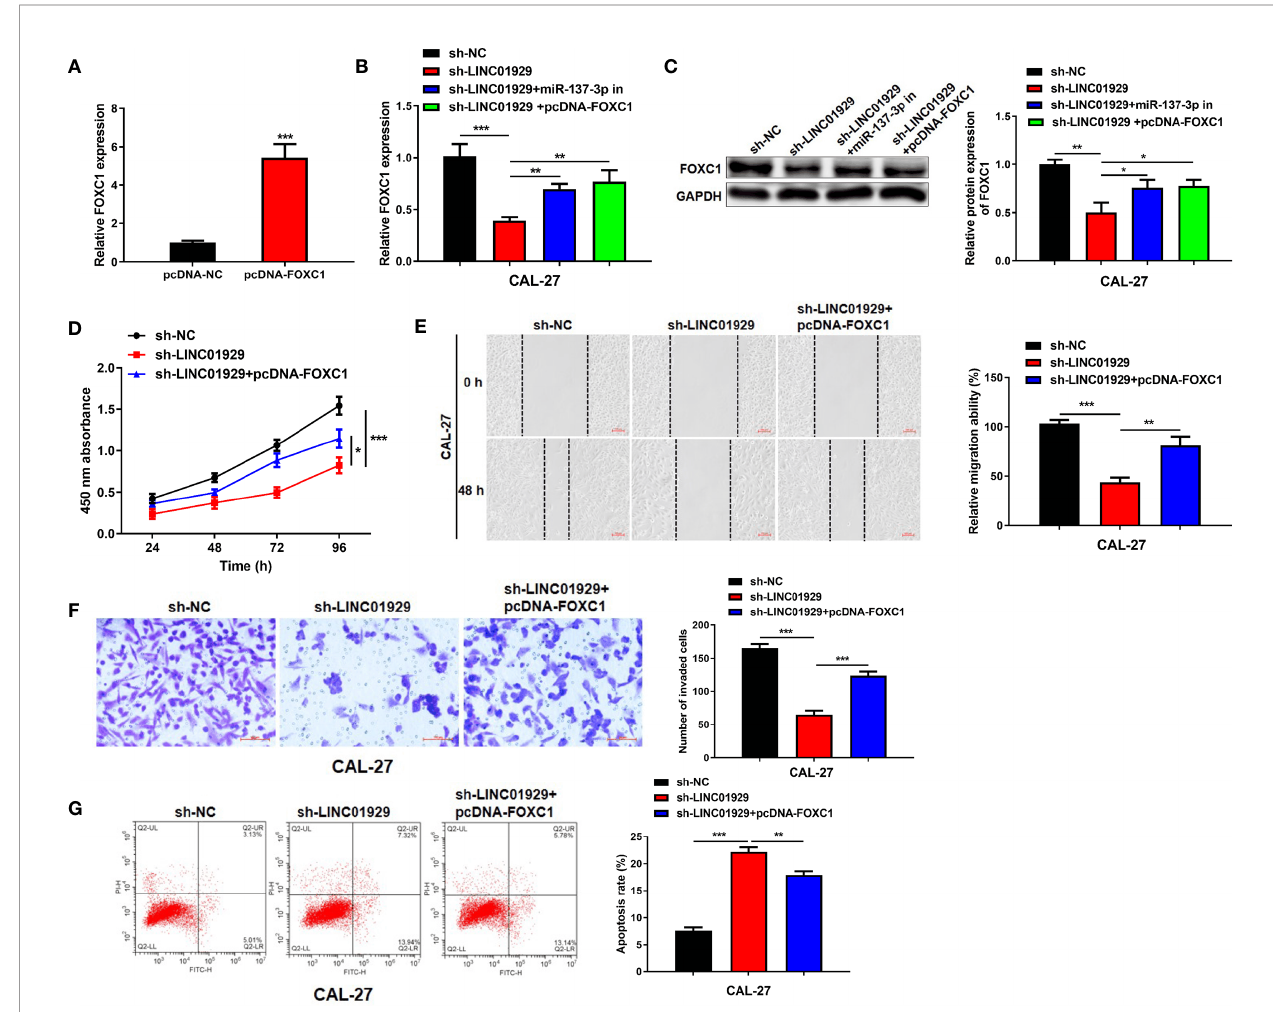
FIGURE 6 | The LINC01929/miR-137-3p/FOXC1 axis regulated the behavior of OSCC cells. (A) The ef fi ciency of FOXC1 overexpression was measured by qRT-PCR. (B) The mRNA and (C) protein expressions of FOXC1 were identi fi ed by qRT-PCR and Western blotting in OSCC cells transfected with sh-NC, sh- LINC01929, sh-LINC01929+miR-137-3p in and sh-LINC01929+pcDNA-FOXC1. (D) The CCK-8 assay was applied to identify the proliferation in each group. The migration (E) and invasion (F) in each group were identi fi ed by wound-healing assay and transwell assay. (G) The fl ow cytometry was applied to measure apoptosis in each